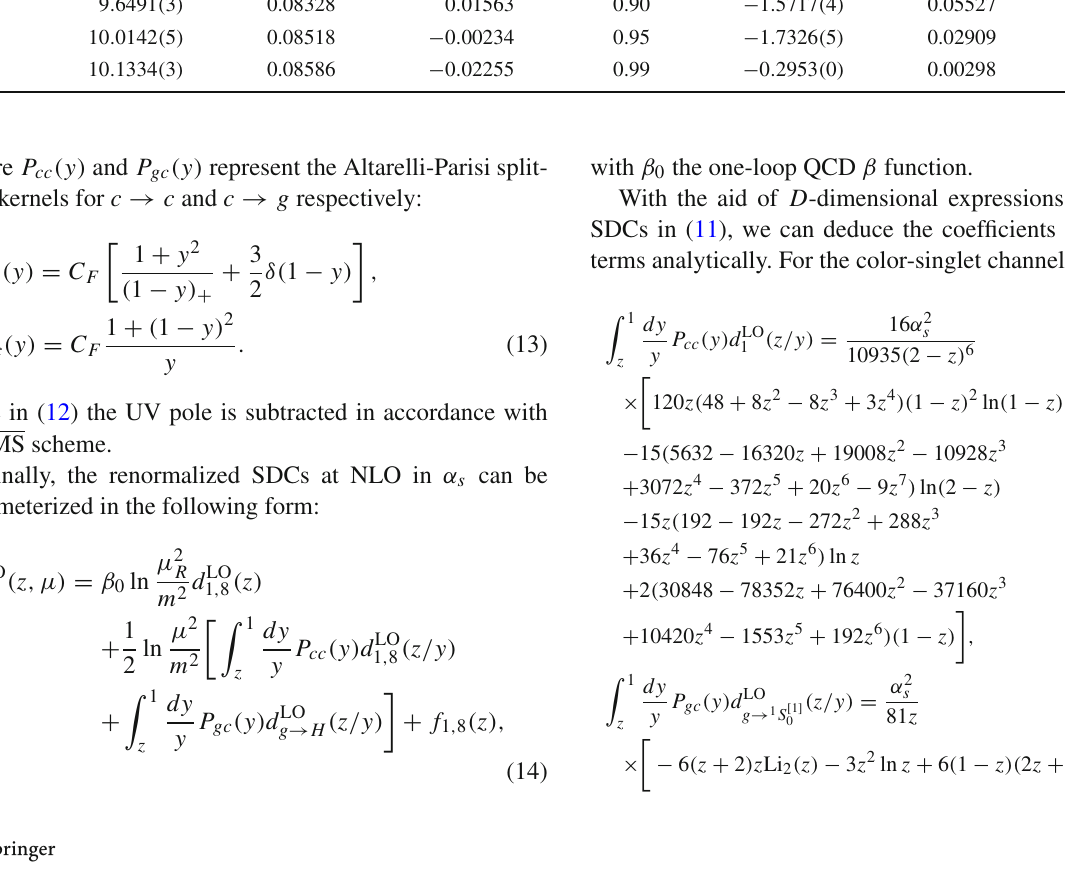
( z ) as introduced in (17). We caution that the actual values 1 , 2 , 3